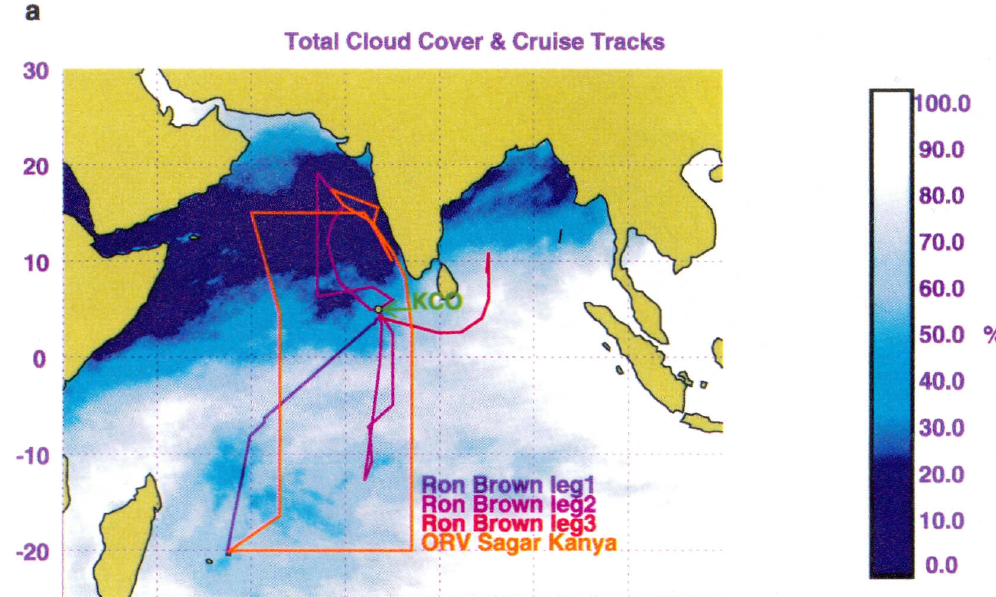
Fig. 11. Cruise tracks of the 1999 RV Sagar Kaya and RV Ronald H. Brown cruises, overlaid on the mean total cloud cover from January– March 1999 (retrieved from the METEOSAT-5 satellite radiances) (from Ramanathan et al., 2001, copyright 2001 by the American Geo- physical Union, reproduced with permission).